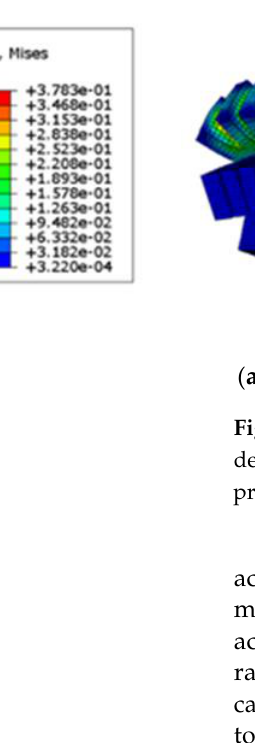
Table 2. Numerical simulation algorithm calculation results.